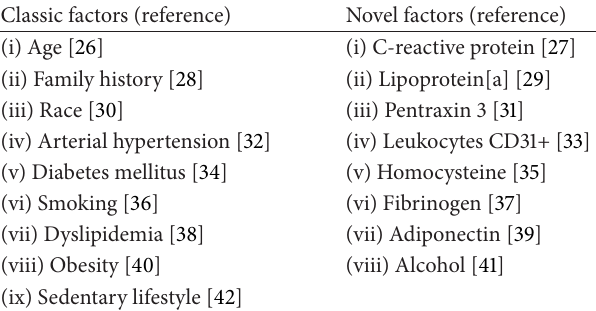
Table 1: Risk factors for cardiovascular